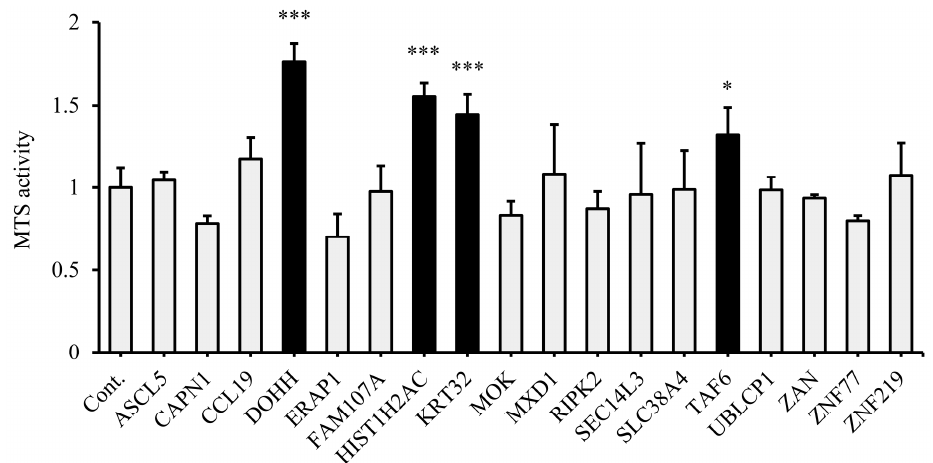
Figure 2. Validation of the candidate genes that induce NRAS signaling-associated cell proliferation by MTS assay. MTS assays were performed on cells in which each candidate gene was activated ( n = 3). Data are presented as mean ± SD. The results compared with control groups were analyzed using one-way ANOVA–Dunnett’s test. * p < 0.05 and *** p < 0.001.